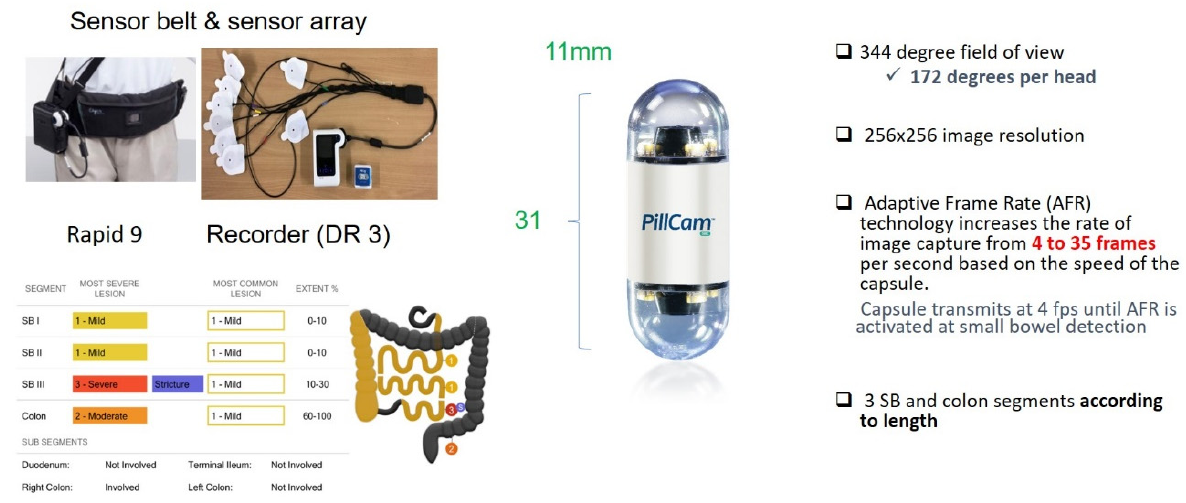
Figure 1. The PillCam Crohn’s capsule.